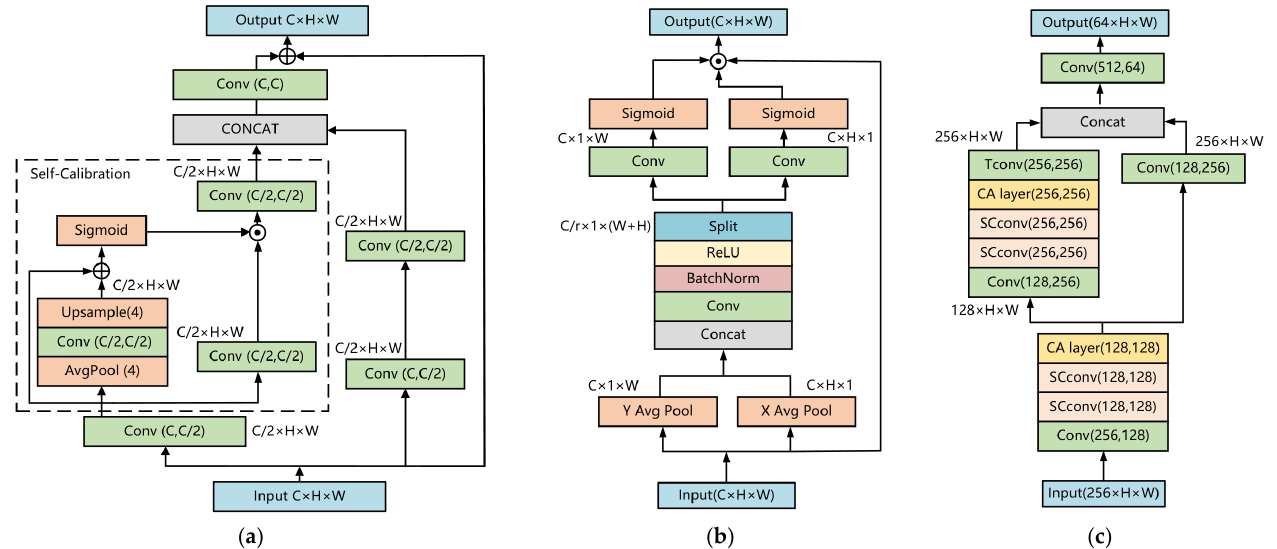
Figure 3. 2D structure of Centerpoint-FE. ( a ) SC conv module; ( b ) CA module; ( c ) 2D backbone.